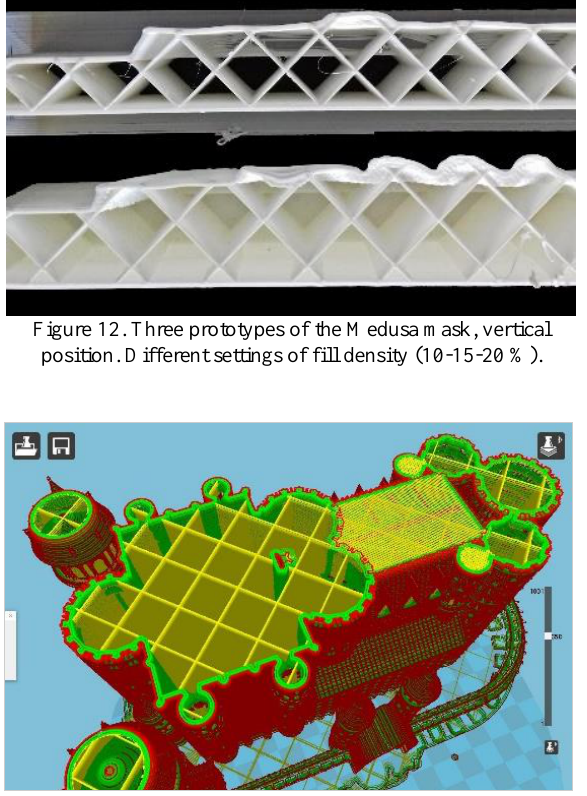
Figure 13. The main screen of Cura;